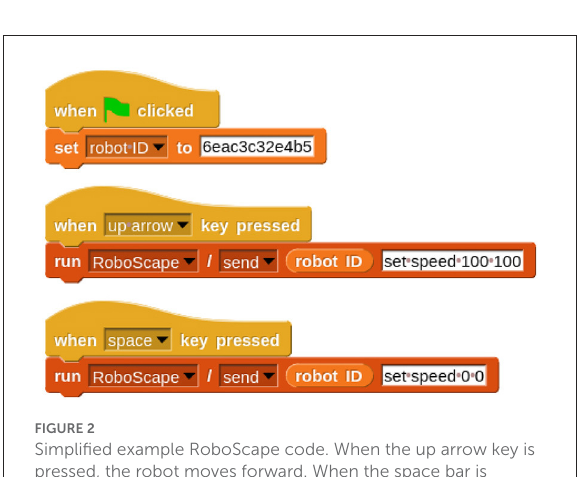
FIGURE2 Simplified example RoboScape code. When the up arrow key is pressed, the robot moves forward. When the space bar is pressed, the robot will